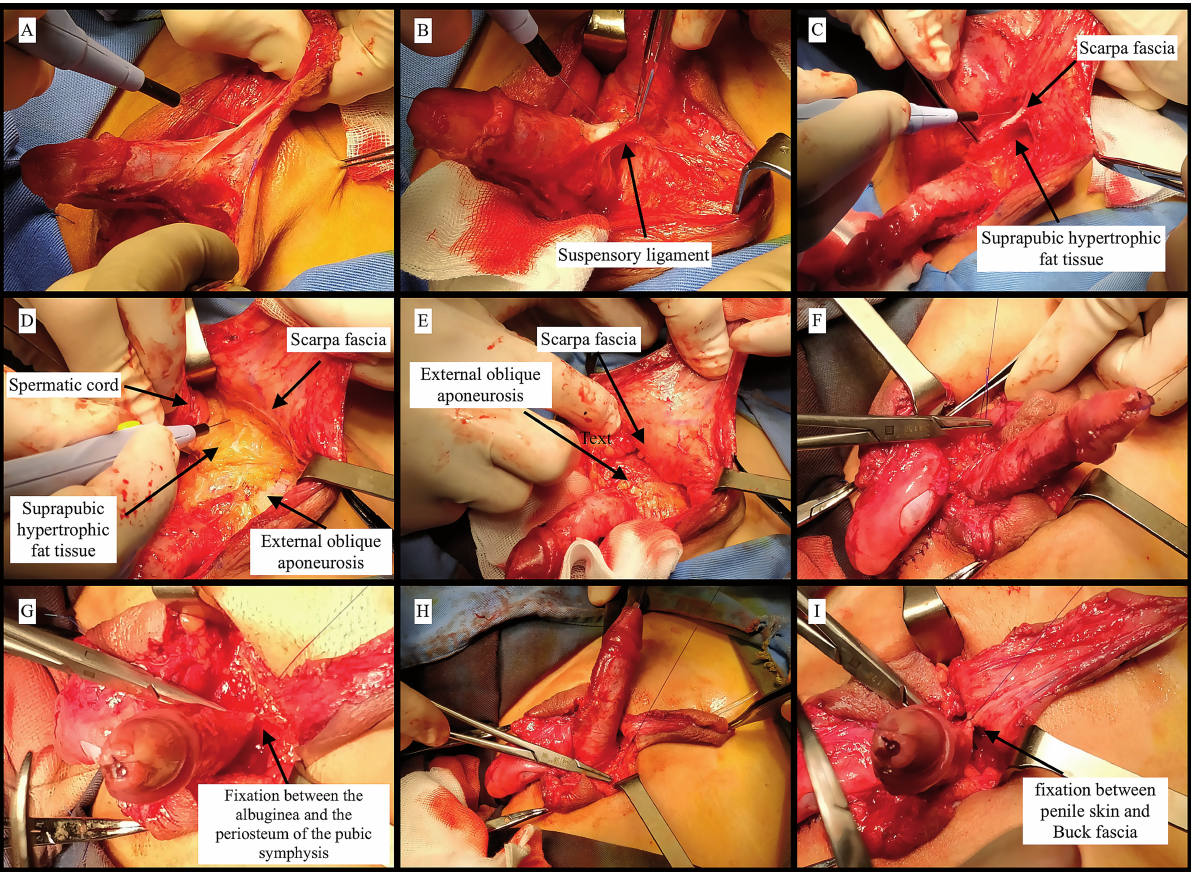
Figure 2 - This image presents the step-by-step procedure for the pubic lipectomy. (A): Penile degloving. (B): Dissection of the fundiform and suspensory ligaments. (C): Detachment of the suprapubic fat from the Scarpa fascia. (D): The hypertrophic fat tissue is dissected, meanwhile the two spermatic cords are laterally traced. (E): The external oblique aponeurosis is visible at the end of the resection. (F-G-H): Fixation of the Buck fascia to the periosteum of the pubic symphysis with absorbable 0-4 polydioxanone suture at 12 o’clock and fixation of the penis to the aponeurosis of the external oblique muscle at 3 and 9 o’clock. (I): Fixation between the penile skin at the base of the penis and the Buck fascia at 12, 3, 6 and 9